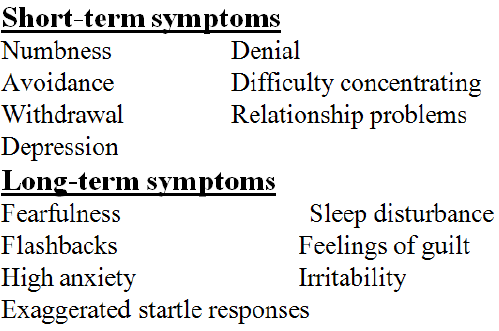
Figure 3. Potential responses to traumatic